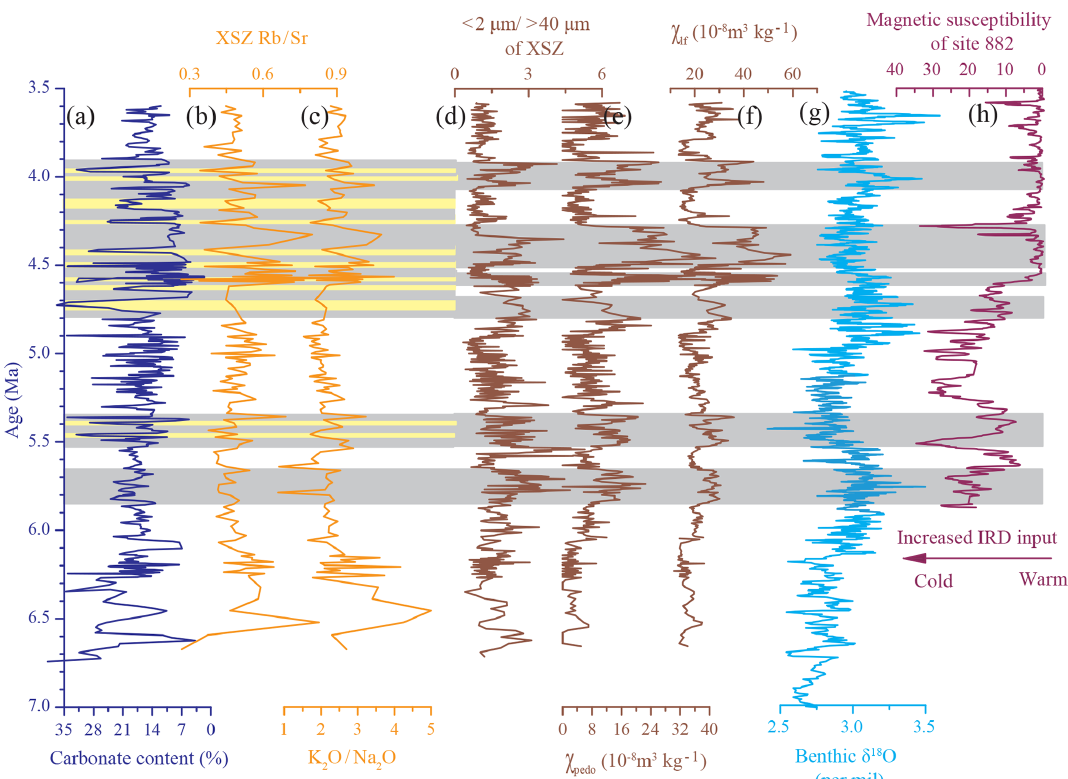
Figure 6. Comparison of the paleoclimatic record of the XSZ red clay section with climate records from elsewhere. (a) Effective precipitation record for the XSZ section. (b–c) Chemical weathering records for the XSZ section. (d–f) Pedogenic intensity records for the XSZ section. (g) Stacked deep-sea benthic foraminiferal oxygen isotope curve compiled from data from DSDP and ODP sites (Zachos et al., 2001). (h) Magnetic susceptibility record from ODP site 882 (Haug et al., 2005). The gray shading indicates relatively wet periods and the light- yellow shading shows intervals of carbonate